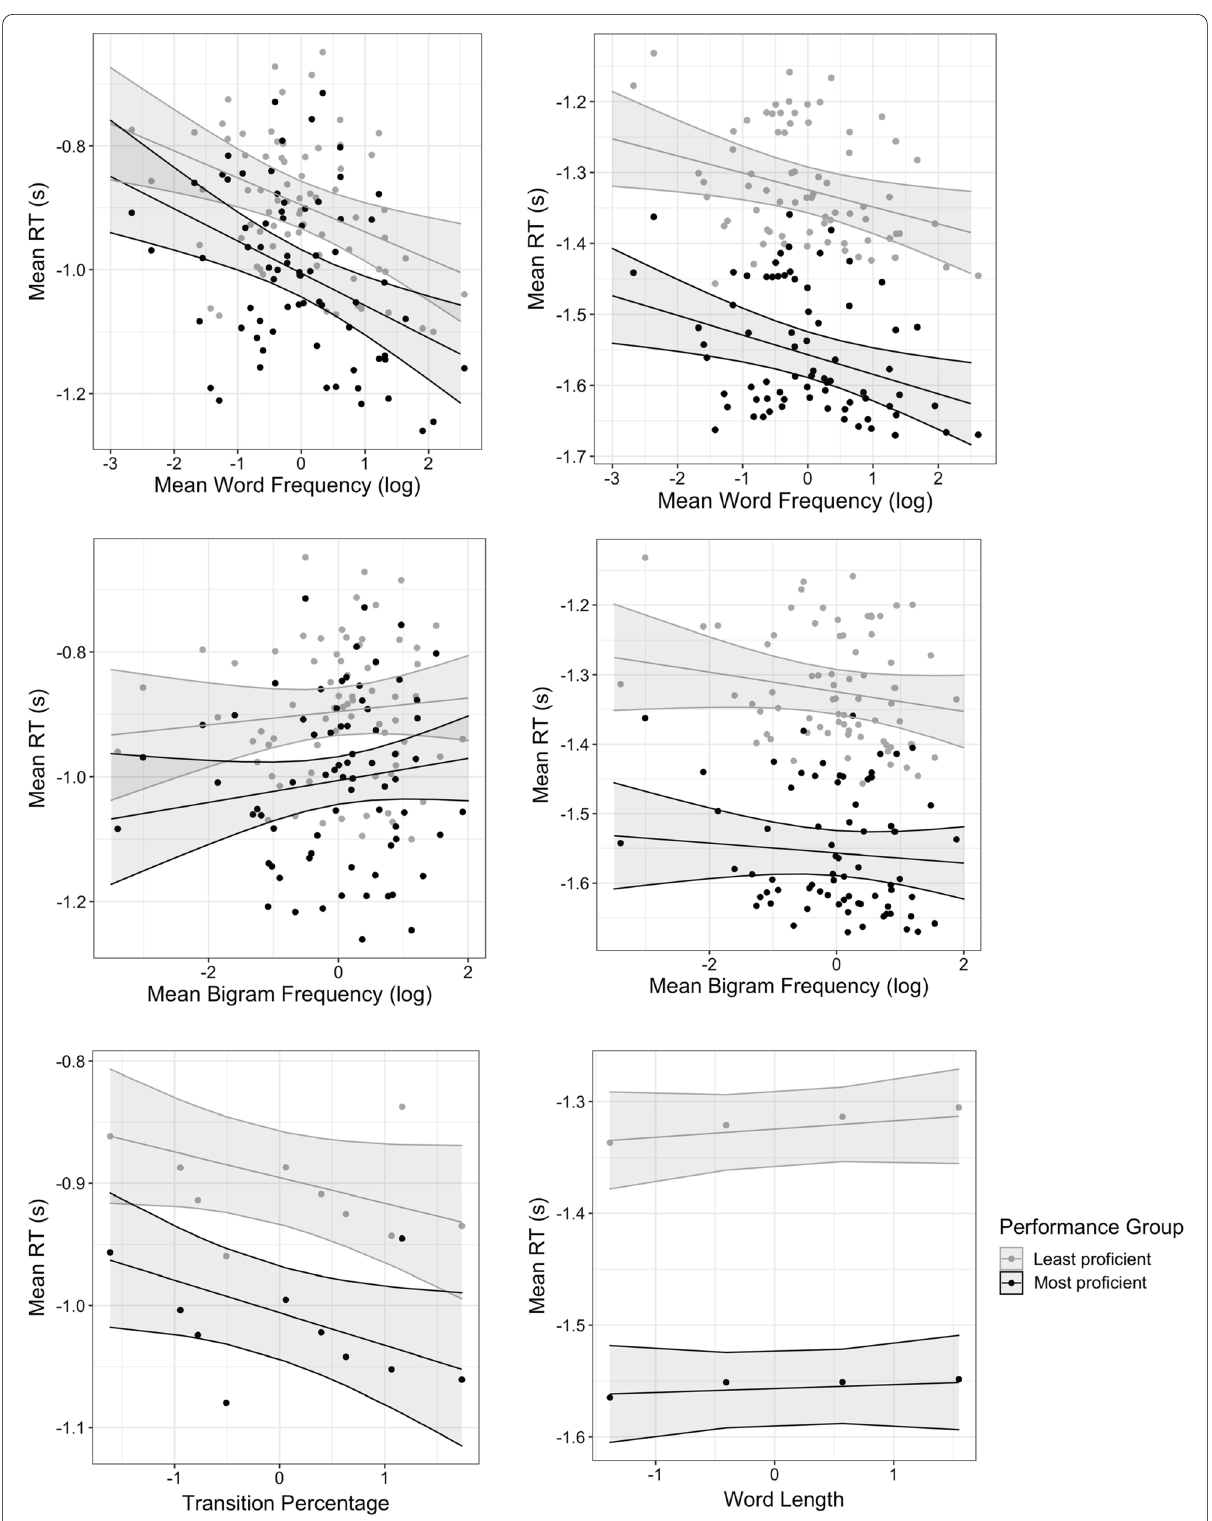
Fig. 7 Effect of word frequency (top), mean bigram frequency (middle) and transition percentage and length (bottom) on RT in picture naming (left) and word copying (right) tasks. RT is plotted in a negative inverse scale, as it was entered in the model. Predicted effects from the mixed model analysis are plotted on top with 95% confidence intervals (obtained from ggeffects package). Continuous predictors are centred and